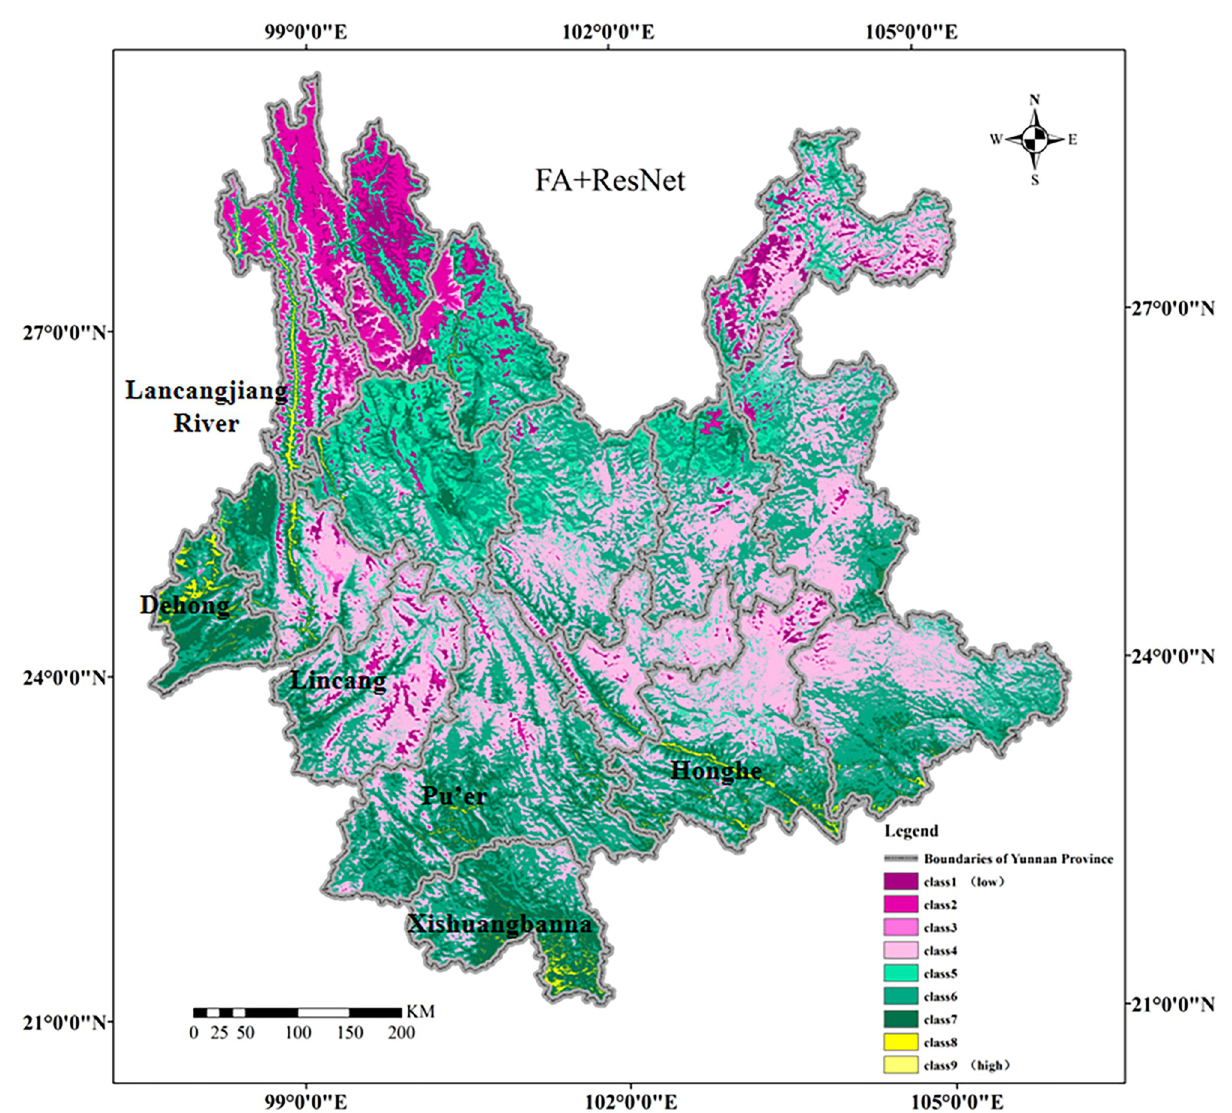
Fig 17. Predicted suitable areas of premium teas by FA+ResNet model. The suitability of premium teas increase gradually from Class 1 to Class 9. Class 9 is the most suitable areas for premium teas growth, while Class 1 is the least suitable area for premium teas growth. Shape file source: republished from http://www.gscloud.cn under a CC BY license, with permission from Geospatial Data Cloud, original copyright [2022]; Own Map output: using ArcGIS 10.8 Software